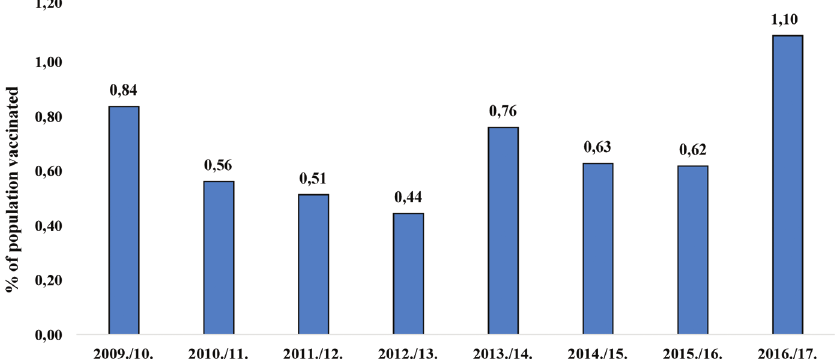
Figure 6. Level of influenza immunization in the Latvian population by influenza seasons from ([68], p.